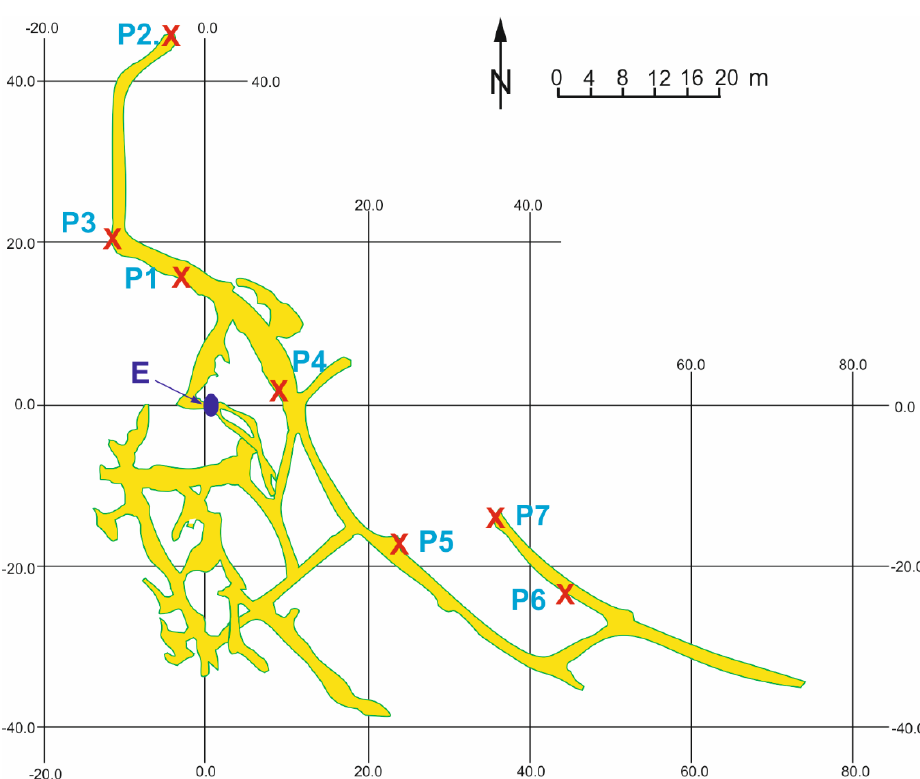
Figure 4. Map of the cave in the Teresa adit inside the Miedzianka Mountain after simplifying [26], with the location of studied sites and collected samples for mineralogical studies. X, location of studied sites and E, entrance.